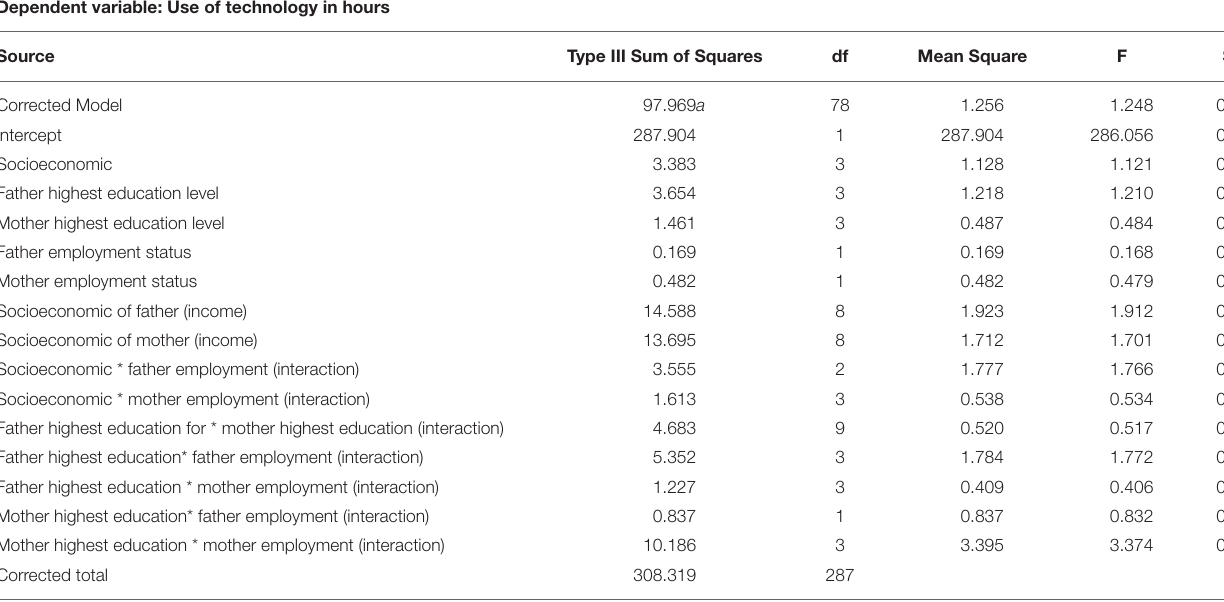
TABLE 10 | Relationship between duration of using technology and children’s family demographics and socioeconomic status.